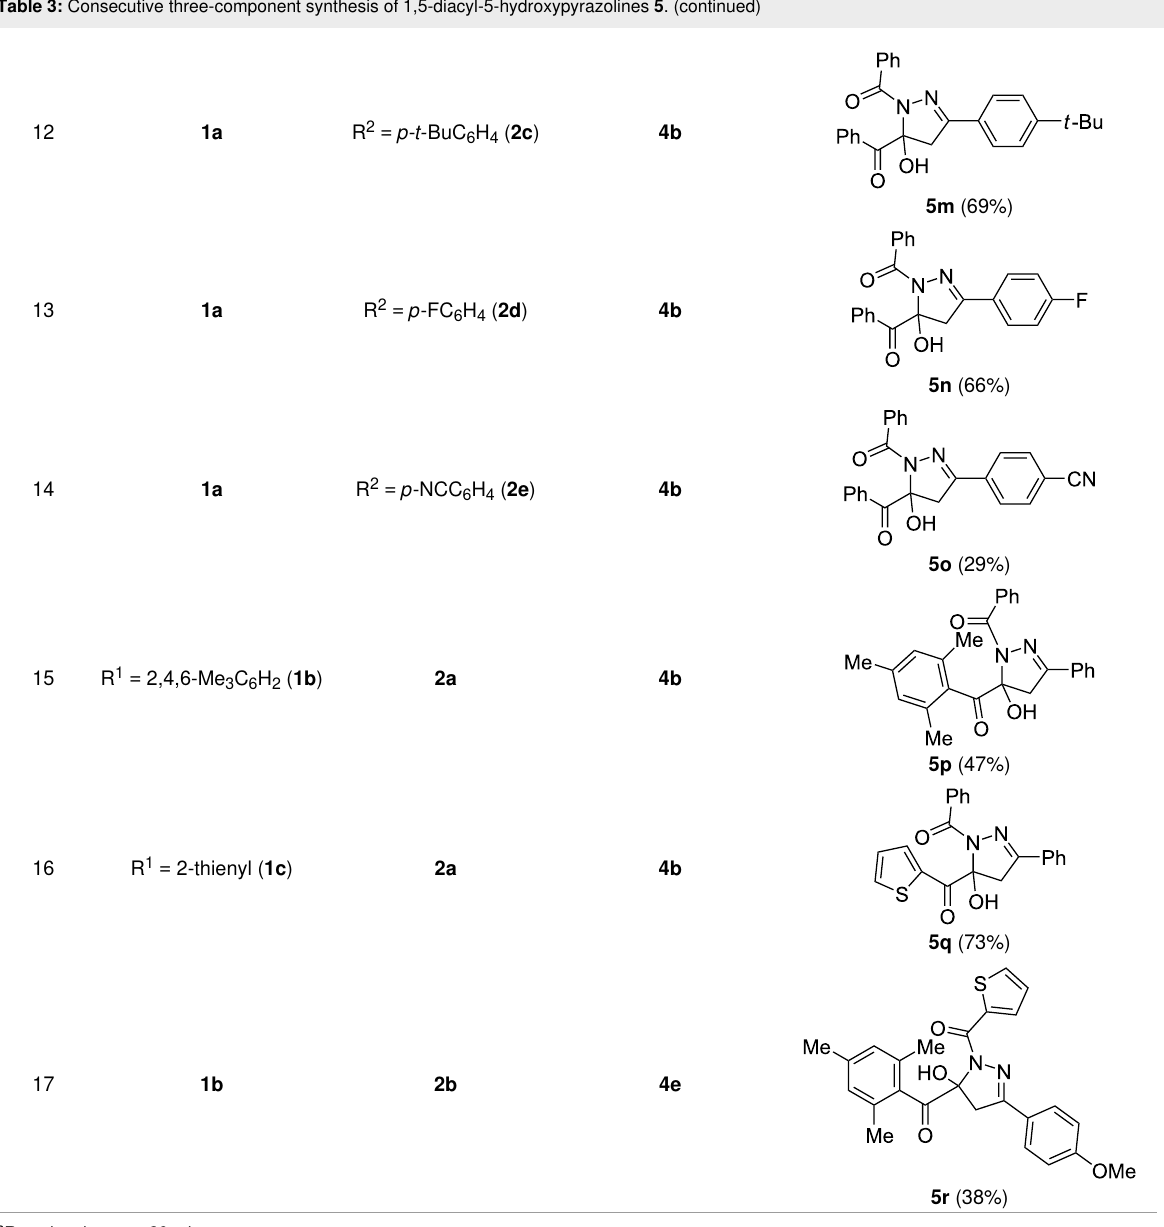
Table 3: Consecutive three-component synthesis of 1,5-diacyl-5-hydroxypyrazolines 5 .